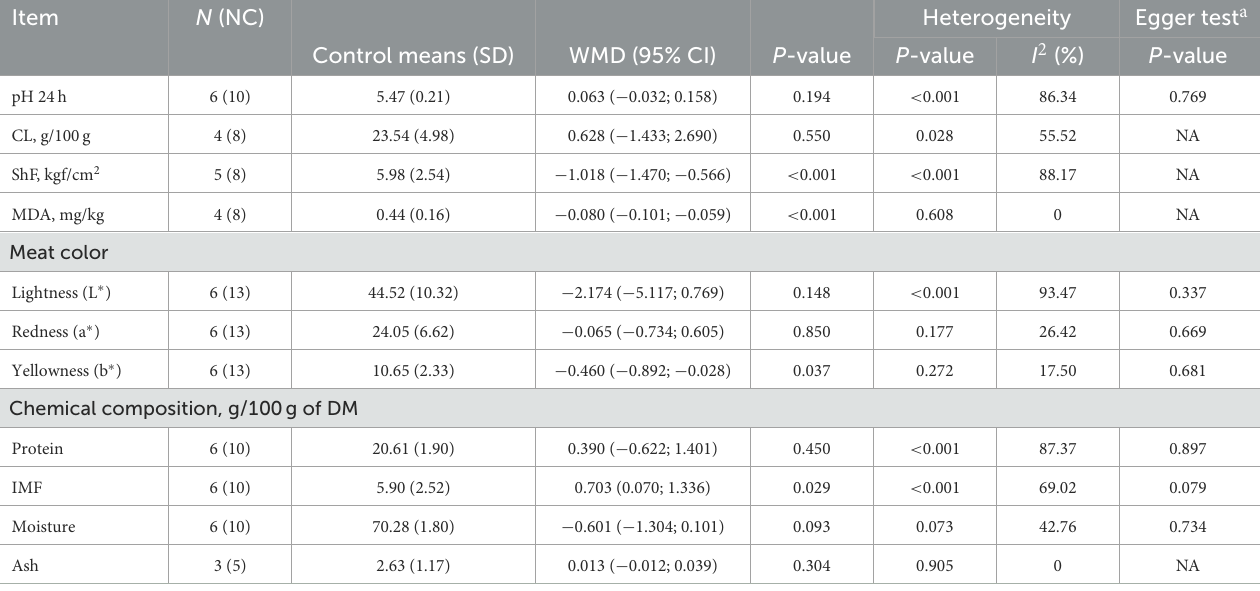
TABLE 5 Meat quality of cattle supplemented with flavonoids.